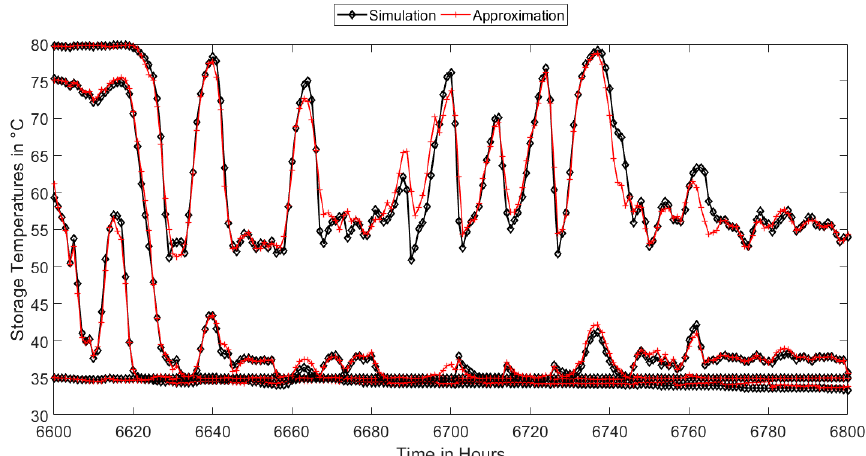
Figure 7. Simulated and predicted temperatures of the four temperature layers in the heat storage, each with a 12-h prediction horizon.